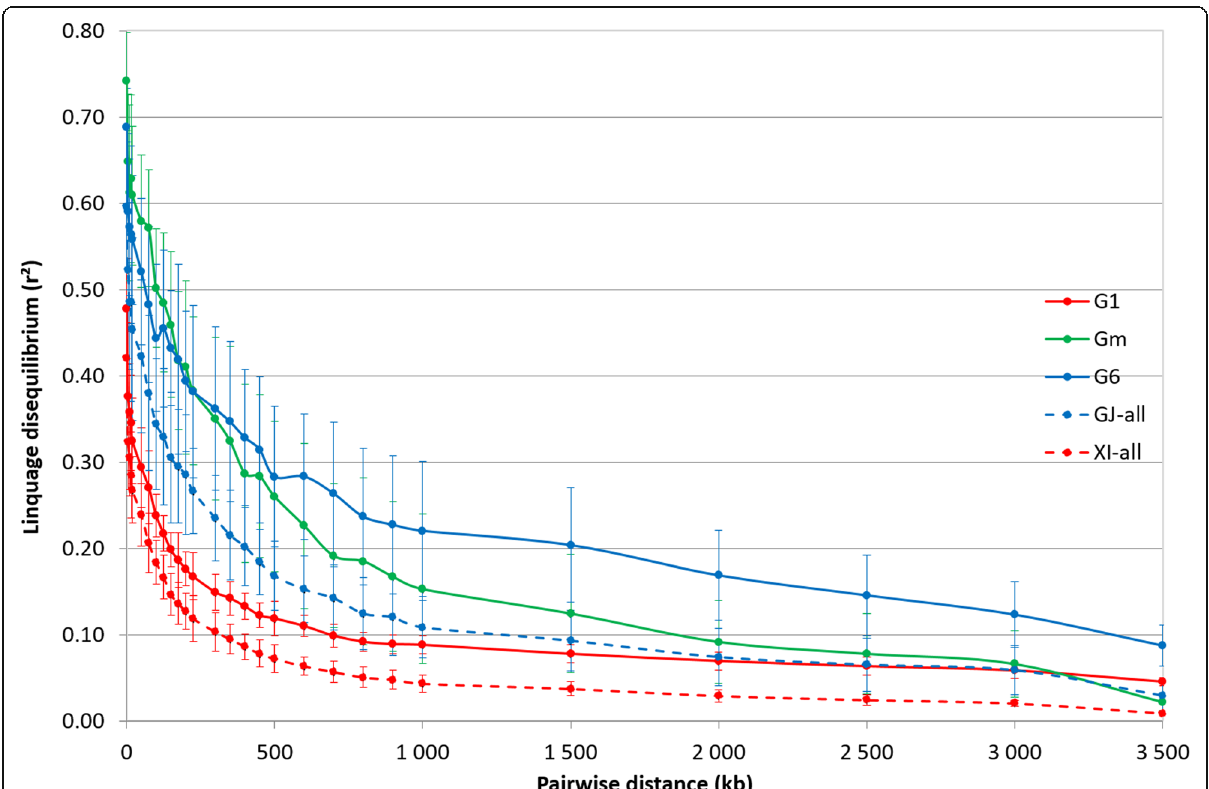
Fig. 3 Patterns of decay in linkage disequilibrium in the indica and japonica population of the Asian panel and the three groups of the Malagasy rice panel, genotyped with 23,981 SNP. The curve represents the average r 2 according to pairwise distance between markers among the 12 chromosomes and the bars represent the associated standard